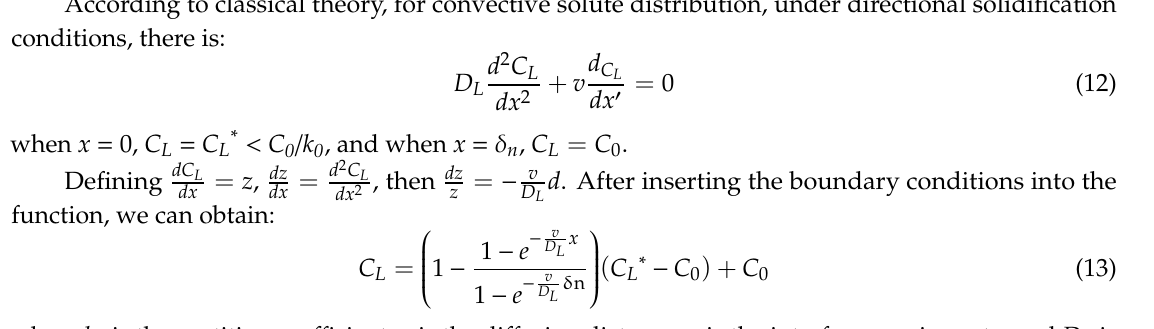
Figure 9. The change of Fe mass fraction in the direction perpendicular to the larger plane of grain under di ff erent Fe content: ( a ) 0.3Fe, ( b ) 0.5Fe, ( c ) 0.7Fe, ( d ) 0.9Fe, ( e ) liquid and solid phase, ( f ) liquid